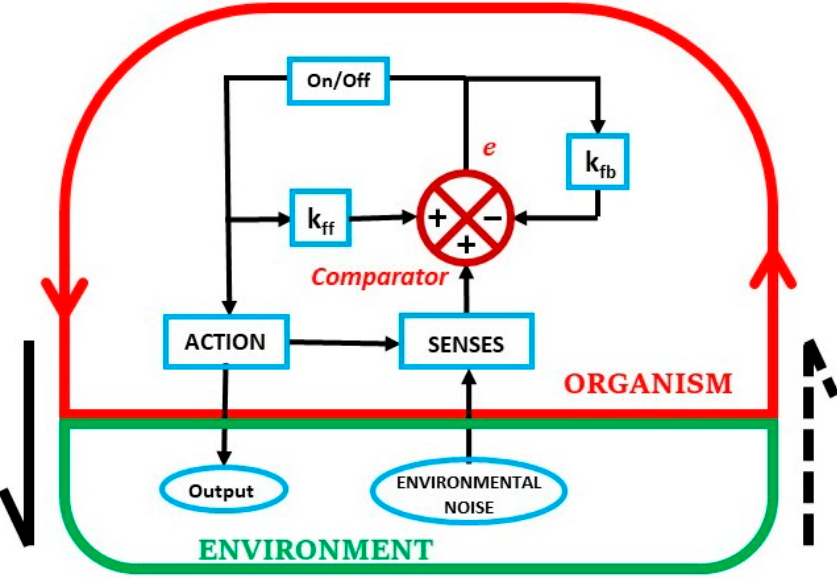
Figure 2. A one-parameter feedback loop simulation of homeorhesis.